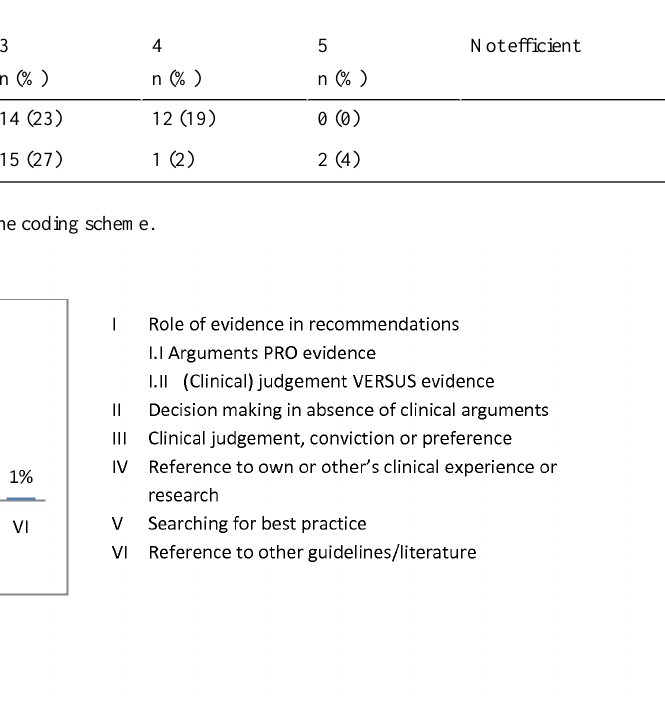
Table 3. Decision-making scores. I would describe the decision-making process as: